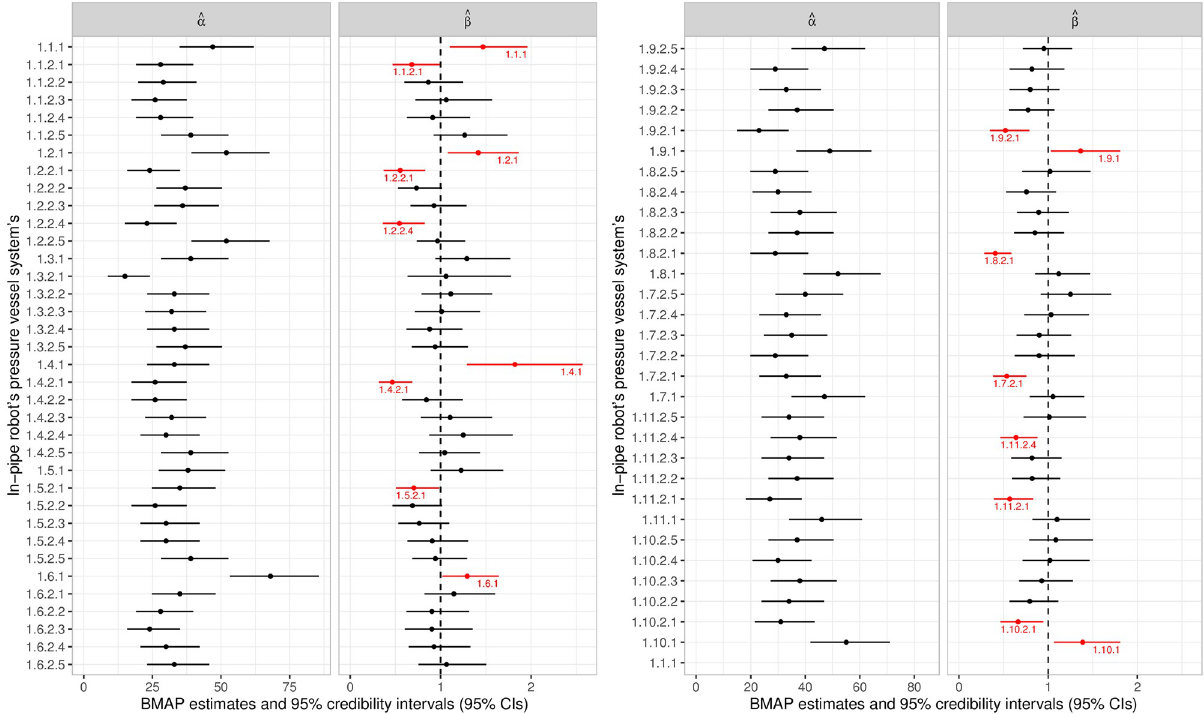
Fig 7. Parameters estimatives for the in-pipe robot’s pressure vessel system’s failure data. BMAP estimates and 95% credibility intervals (95% CIs) for the model parameters.